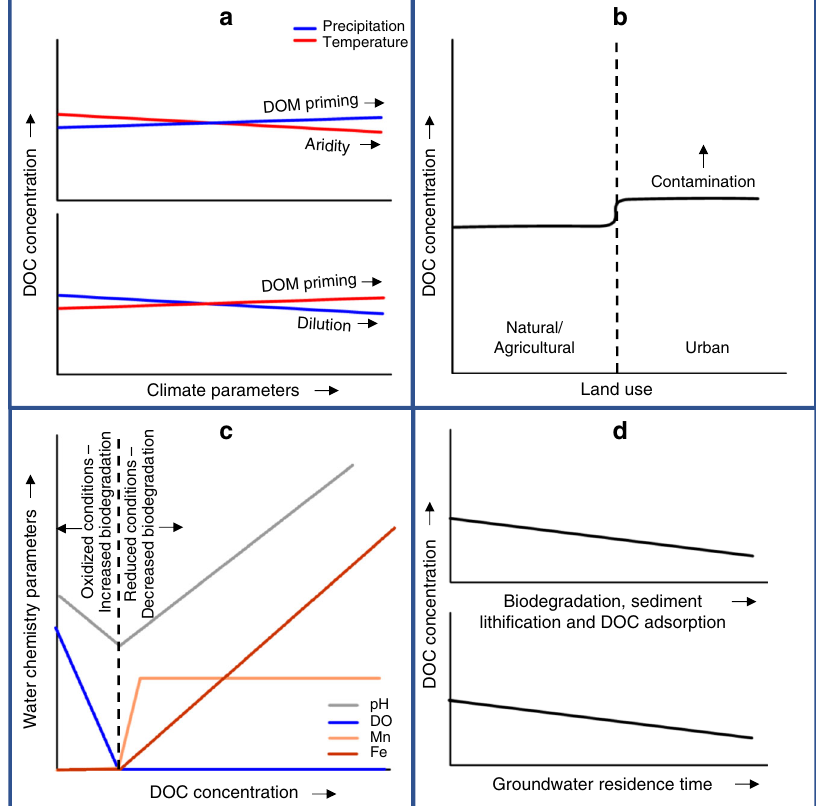
Fig. 3 Conceptual model summarizing drivers of change in groundwater DOC concentrations. a Climate parameters: in arid climates, groundwater DOC concentrations increase with increased precipitation due to the priming of organic matter by microbes under warm and increasingly wet conditions. Increased temperatures in arid environments reduced groundwater DOC due to increasing aridity. Precipitation in humid environments decreases groundwater DOC concentrations due to dilution, while temperatures increase DOM priming by microbes. b Urban land use contributes to groundwater DOC through contamination, for example through leaking septic and sewer systems. c Water quality parameters and groundwater DOC concentrations are linked and are largely controlled by redox conditions (NB: this panel shows variables, where DOC is the driver for the observed changes in